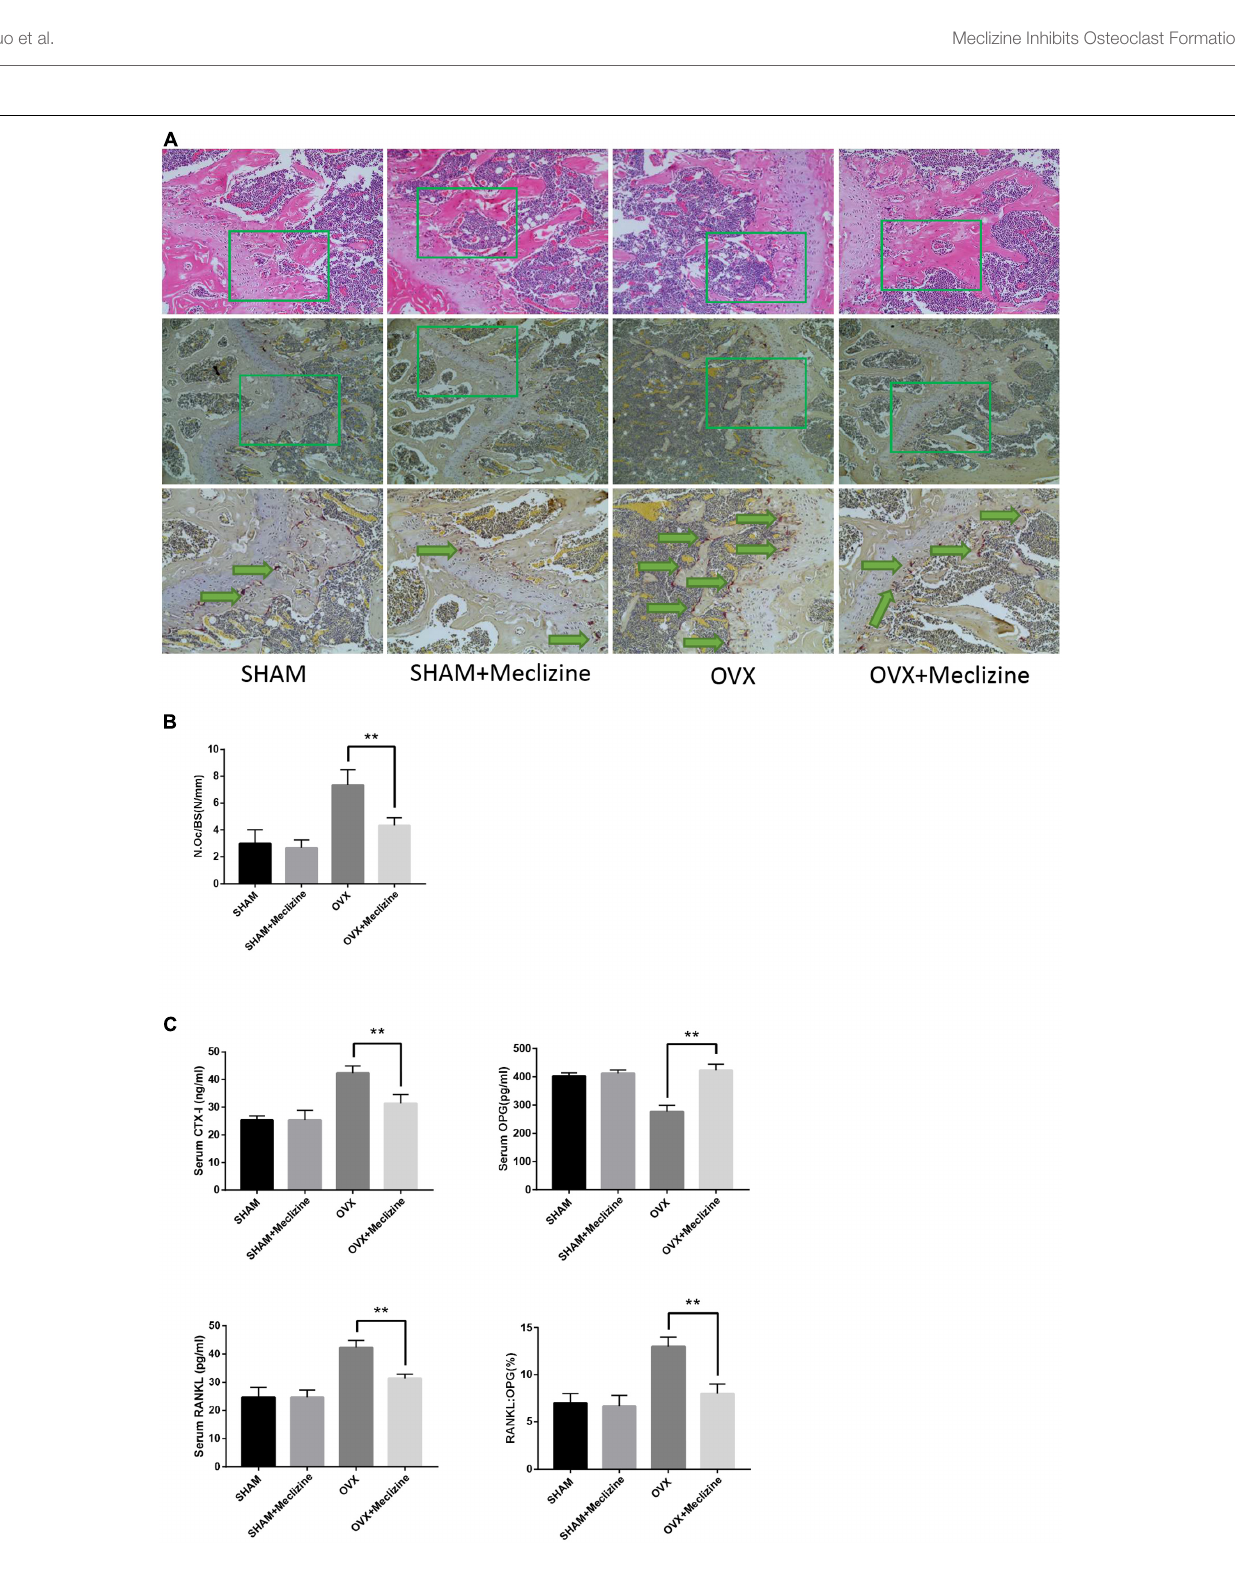
Frontiers in Pharmacology |